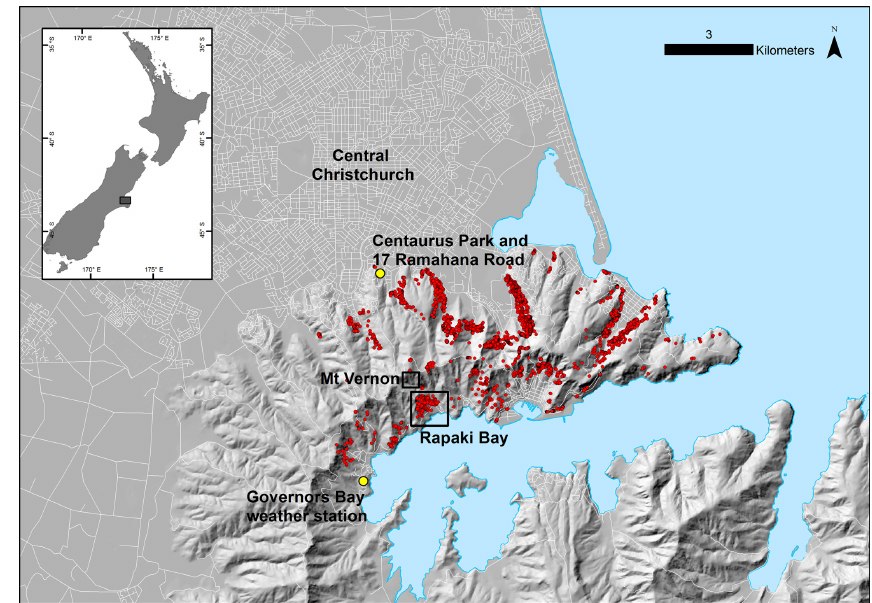
Figure 1. Location map of Christchurch and the Port Hills showing sites examined in this study. Red dots show mapped rockfall deposit locations ( n =